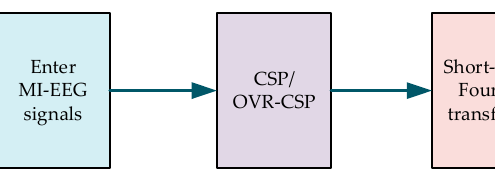
Figure 6. DCN-ResNet18 neural network structure.